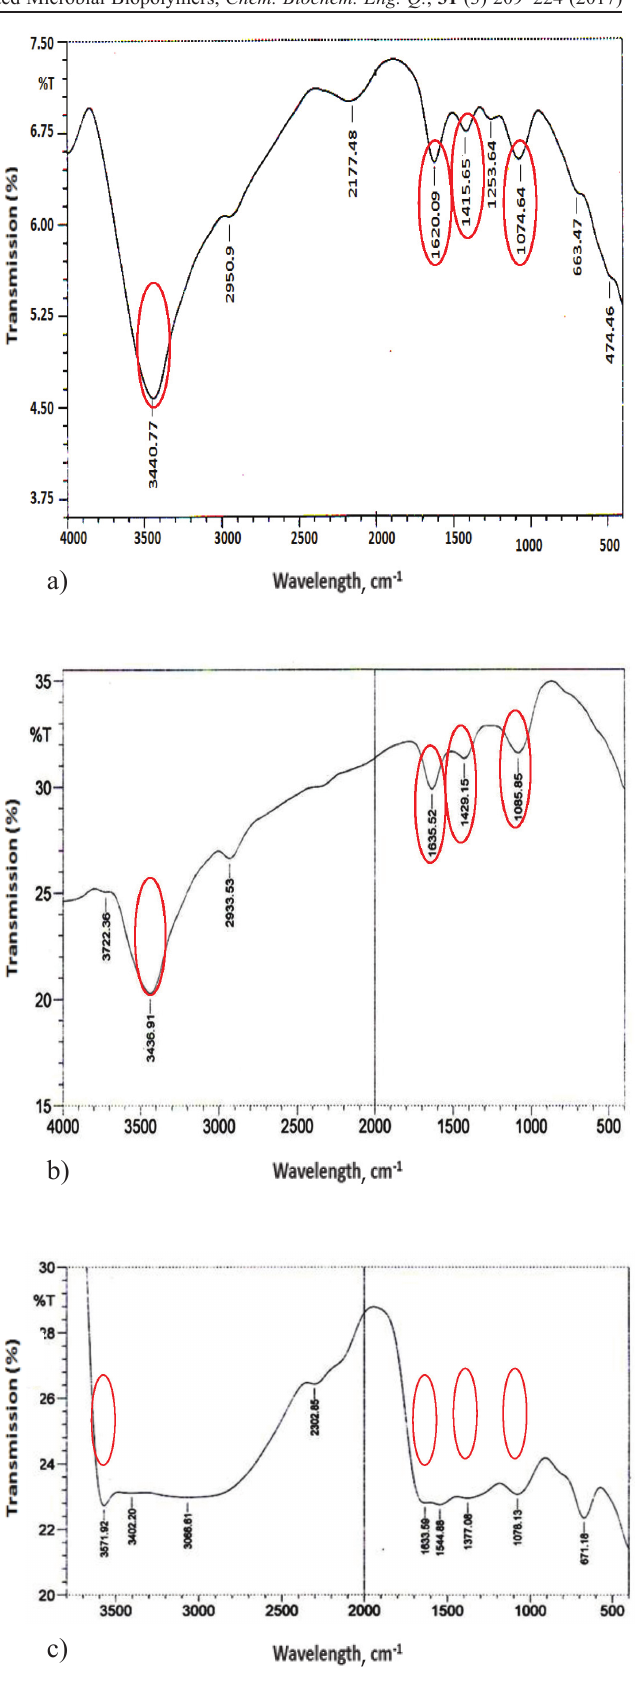
Fig. 1 – FTIR analysis of the three purified biopolymers a) Bacillus velezensis, b)Bacillus mojavensis, and c)